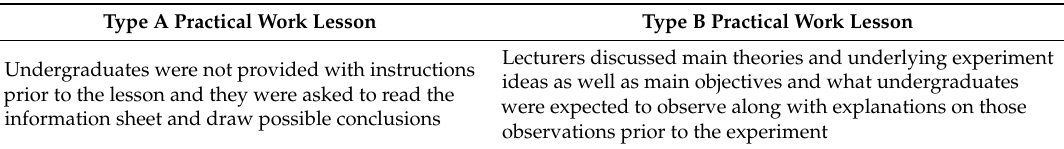
Table 2. Two types of instruction (A, B) during practical work